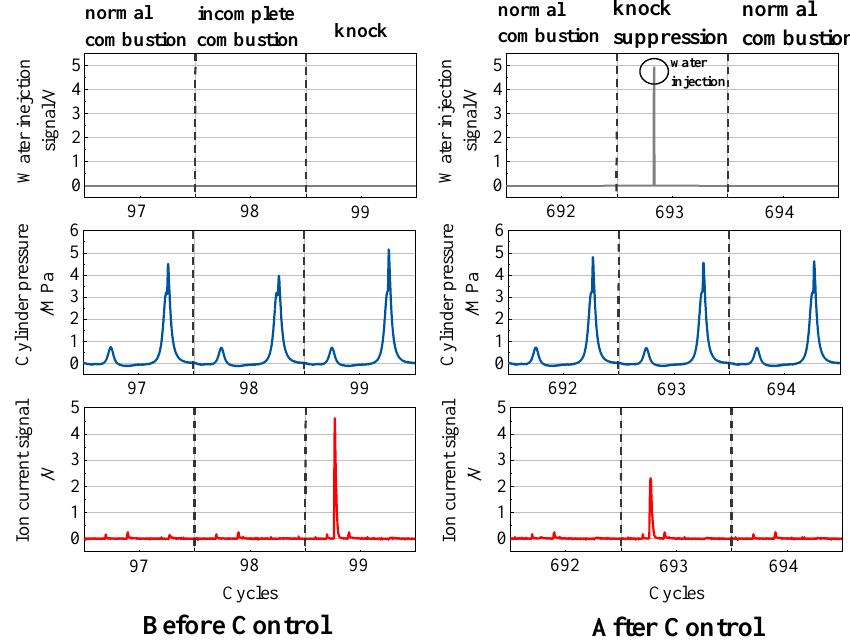
Figure 11. Water injection, cylinder pressure, and ion current signals of three continuous cycles before and after control.